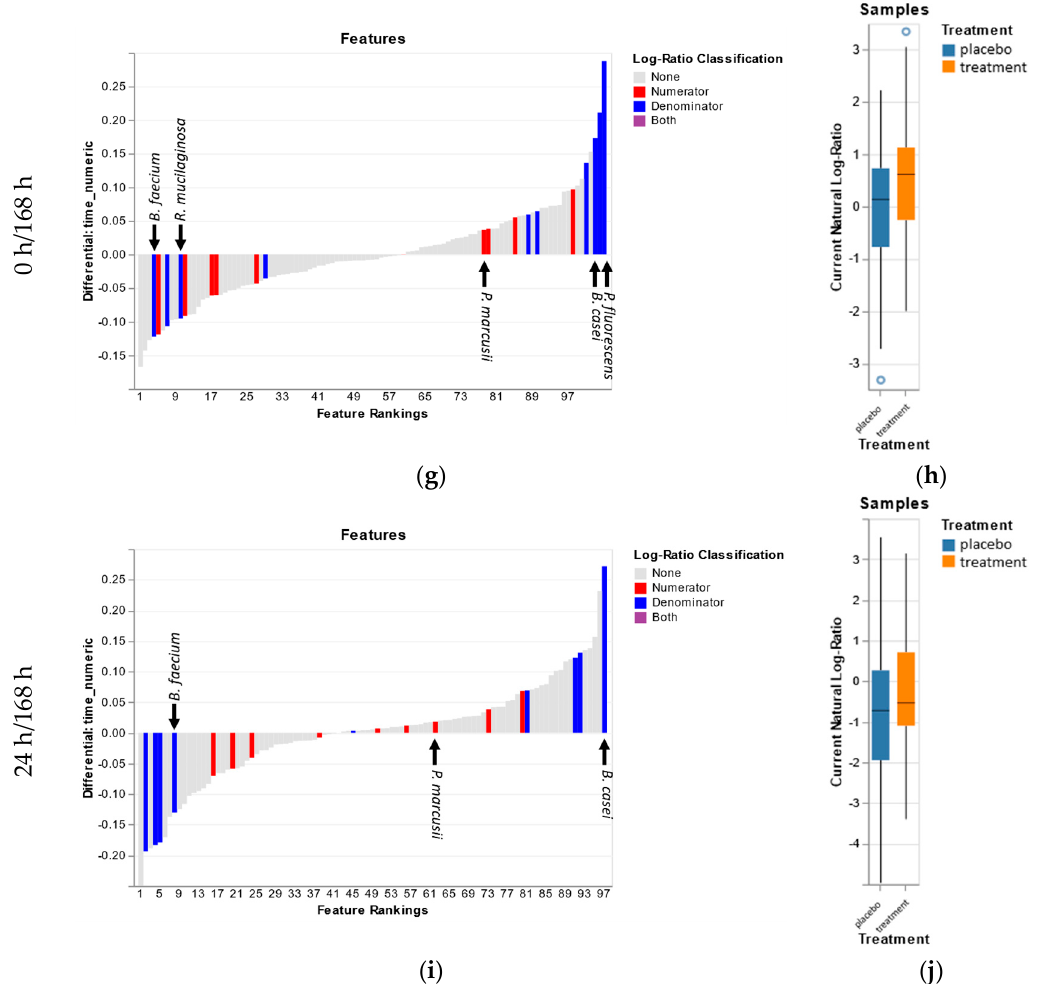
Figure 3. The rank plot ( a , c , e , g , i ) of the top 10% of organisms that contribute to the treatment/placebo differential plotted against their respective ranking against time. The effect of the treatment on the top 10% of contributing organisms is visualized as a boxplot ( b , d , f , h , j ).